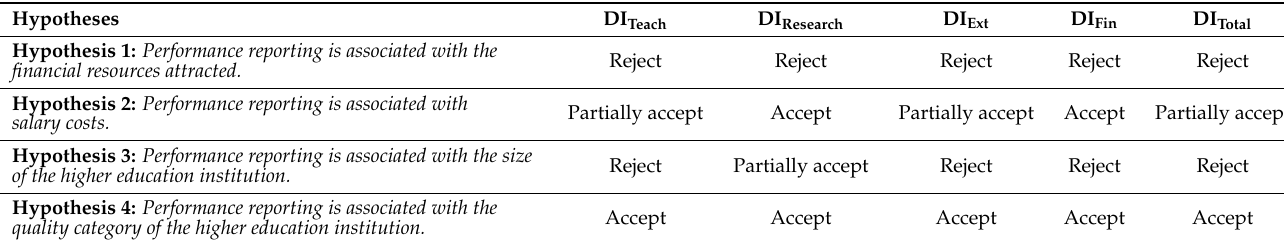
Table 10. Hypotheses